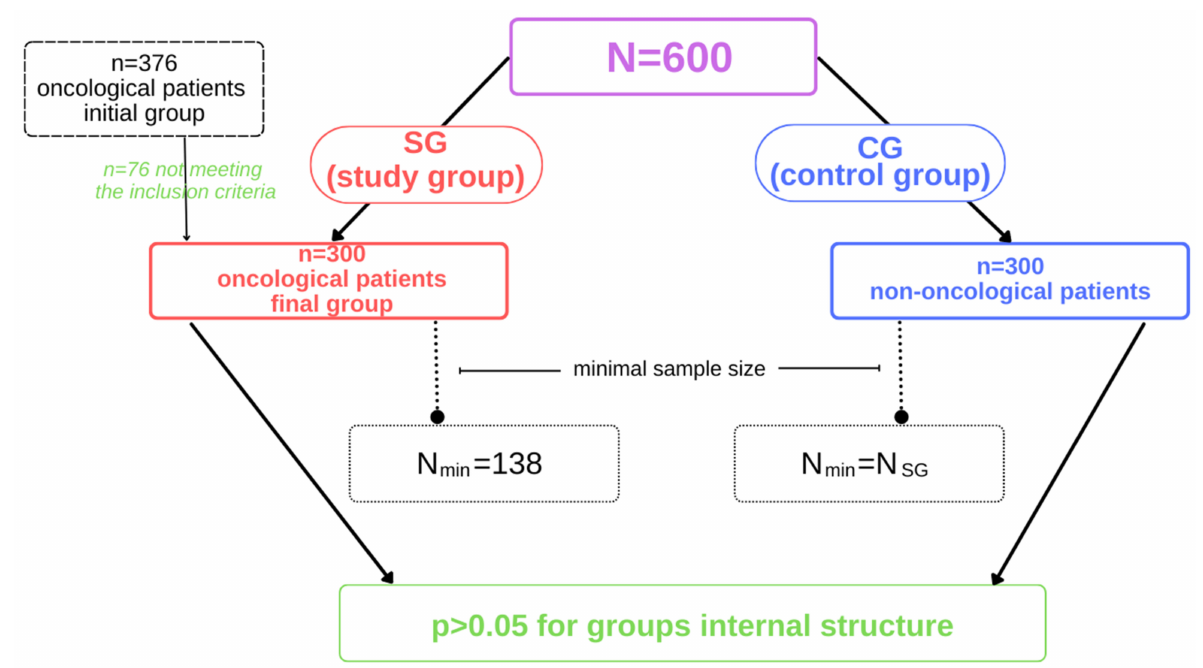
Figure 1. Participants in the